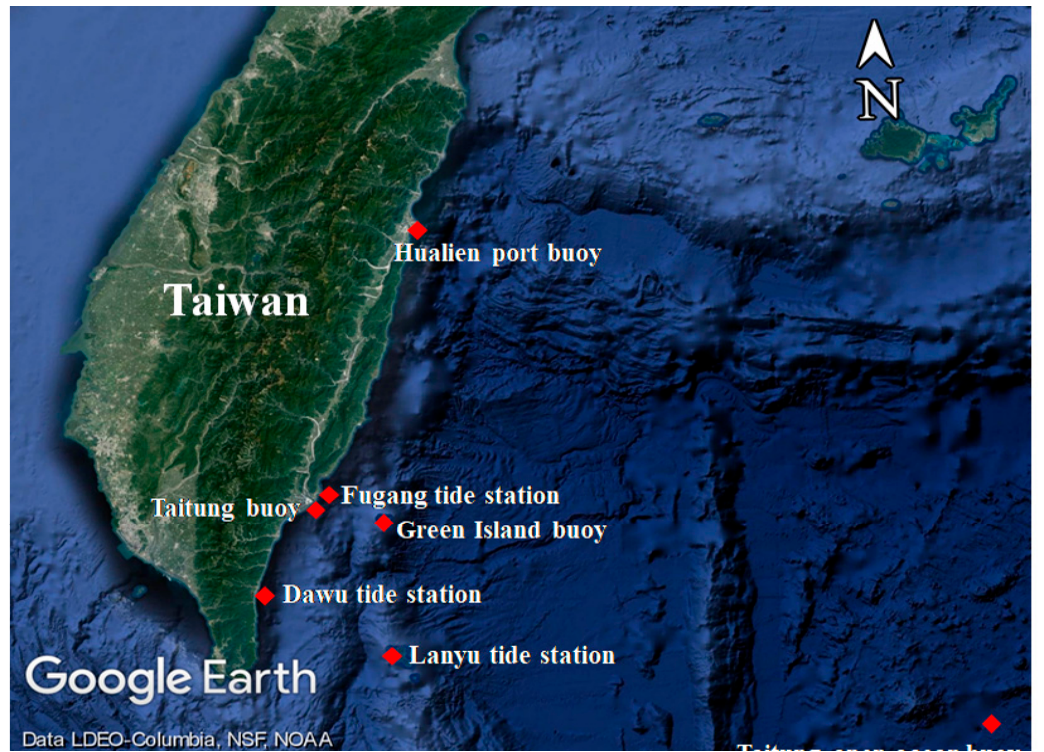
Water 2020 , 12 , x FOR PEER REVIEW Figure 5. Locations of tide stations and wave buoys.